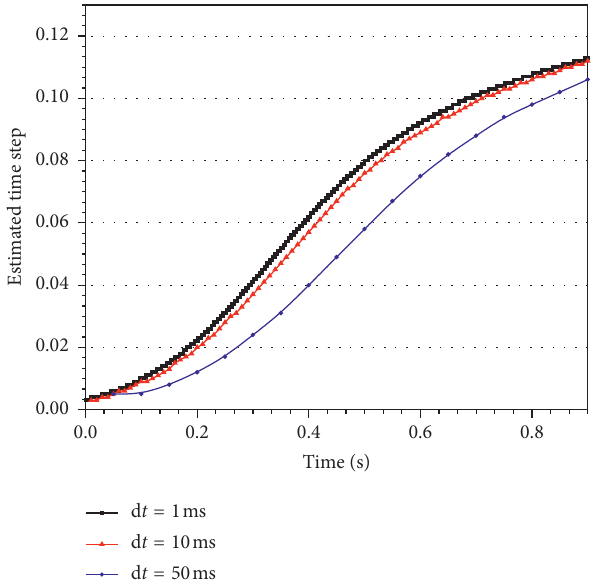
Figure 8: Estimated time step during